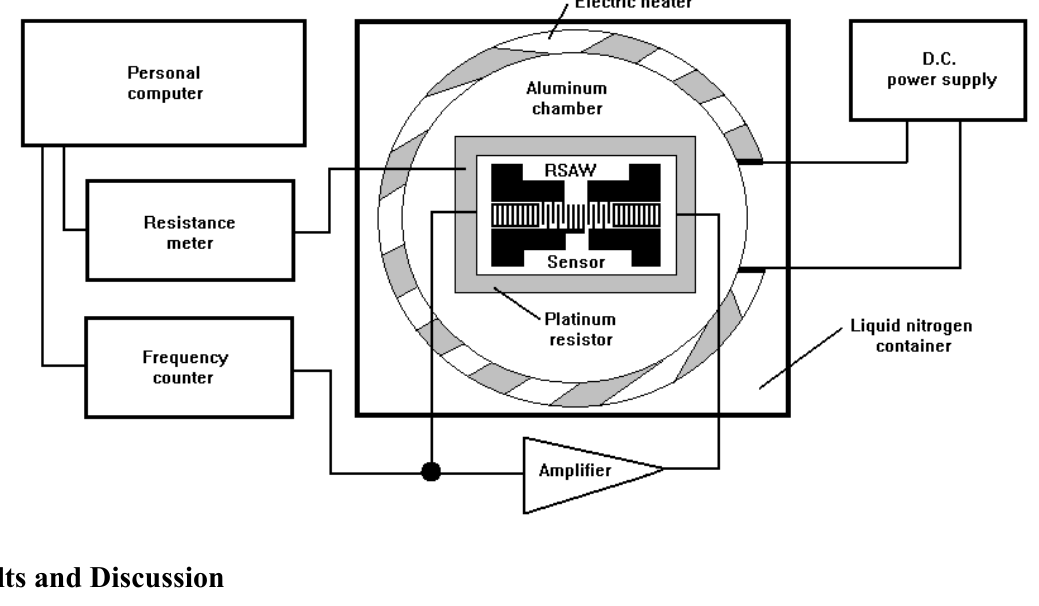
Figure 6. Block schematic of the temperature frequency characteristics (TFC) measurement